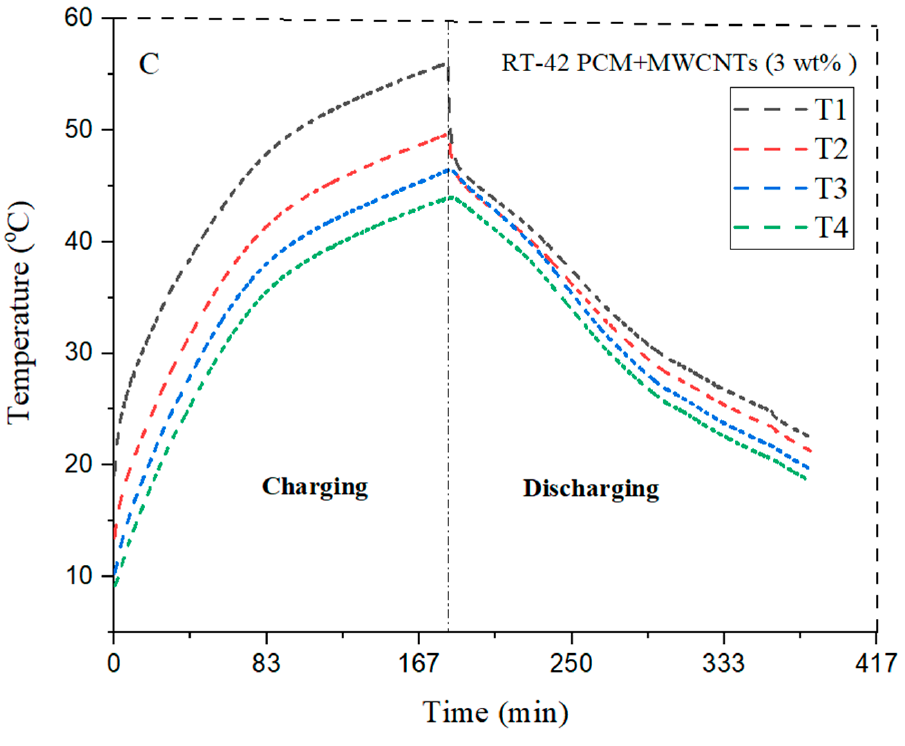
Figure 9. Comparison of different configurations with 3 wt% of NePCM ( A ) circular, ( B ) square, and ( C ) triangular fins.